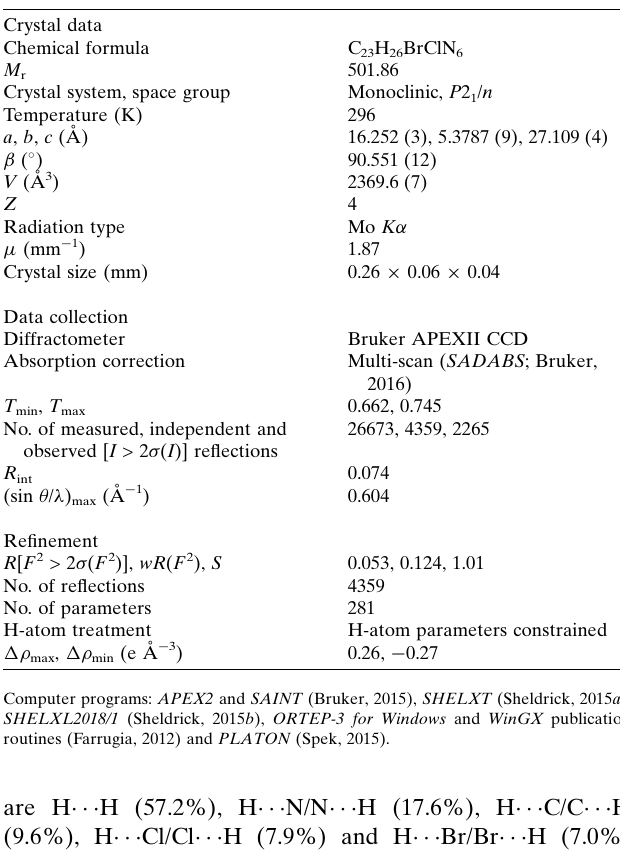
Table 1 Hydrogen-bond geometry (A˚ , (cid:2) ).